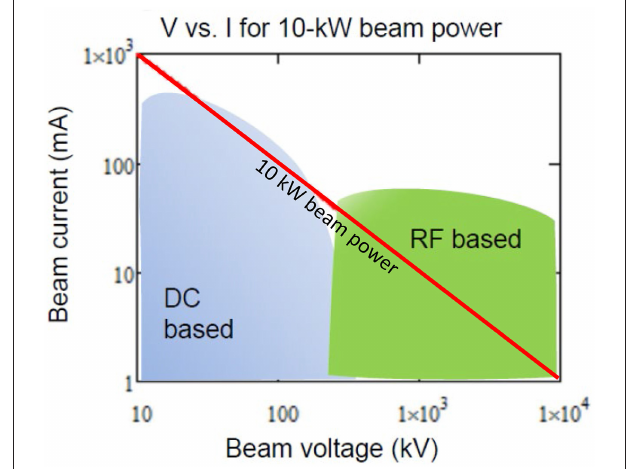
FIGURE 1 | Operating beam current vs. beam voltage for a 10-kW electron beam as generated by a DC-based electrostatic accelerator (blue) and an RF-based linear accelerator (green). The red line indicates a constant beam power of